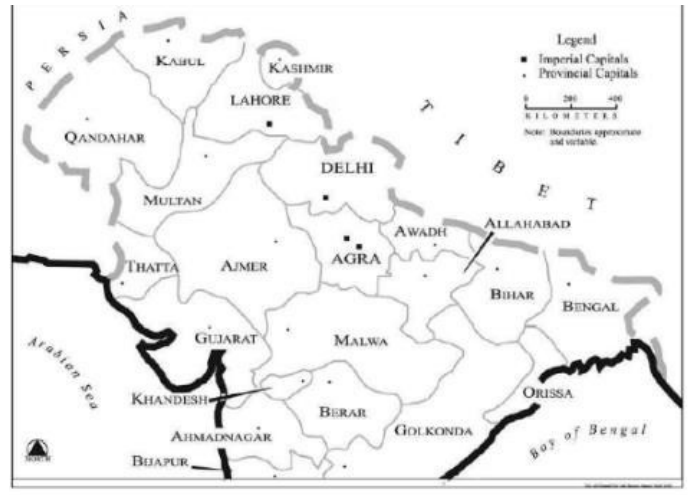
Figure 1. Lahore during Mughal